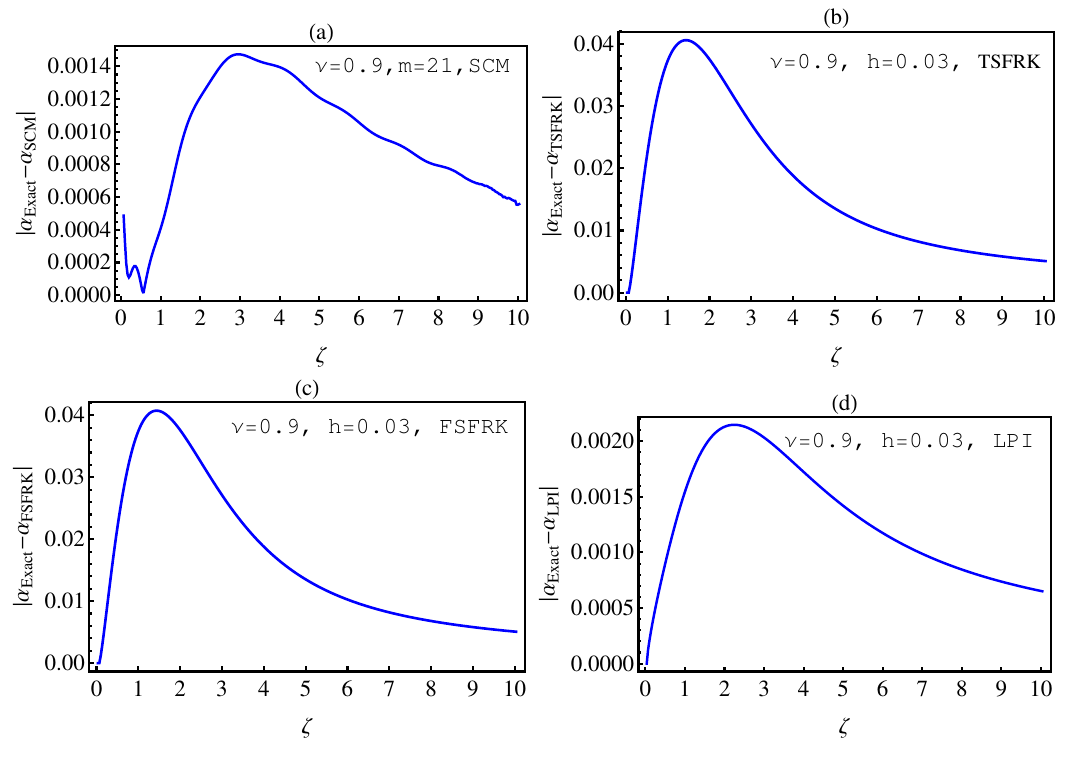
Figure 2. The absolute error between the exact and the numerical solutions of (6) based upon SCM ( a ); TSFRK ( b ); FSFRK ( c ) and LPI ( d ), respectively, for ν = 0.9, h = 0.03, m = 21, K = 1.0, α ( 0 ) = 0.75.